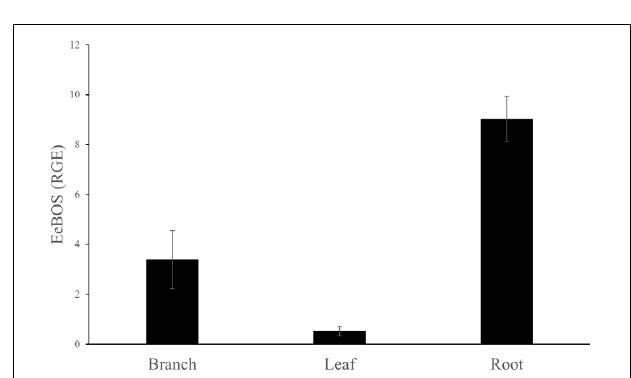
FIGURE 5 | Relative gene expression of EeBOS in different tissues. The reference gene used was EeEF1. Each bar represents the average of at least three biological replicates ±